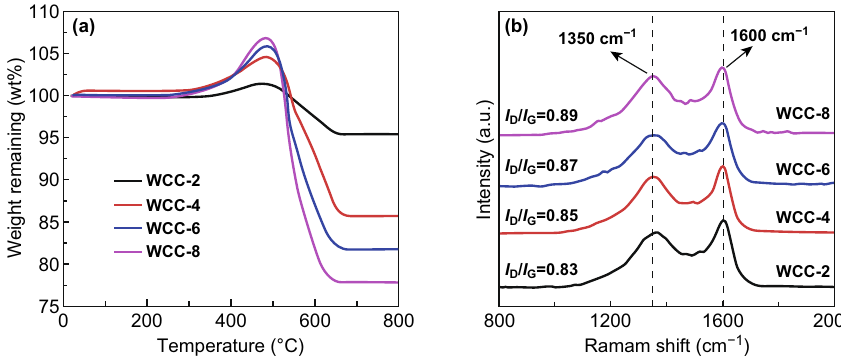
Fig. 4 a TG curves and b Raman spectra of different tungsten carbide/carbon